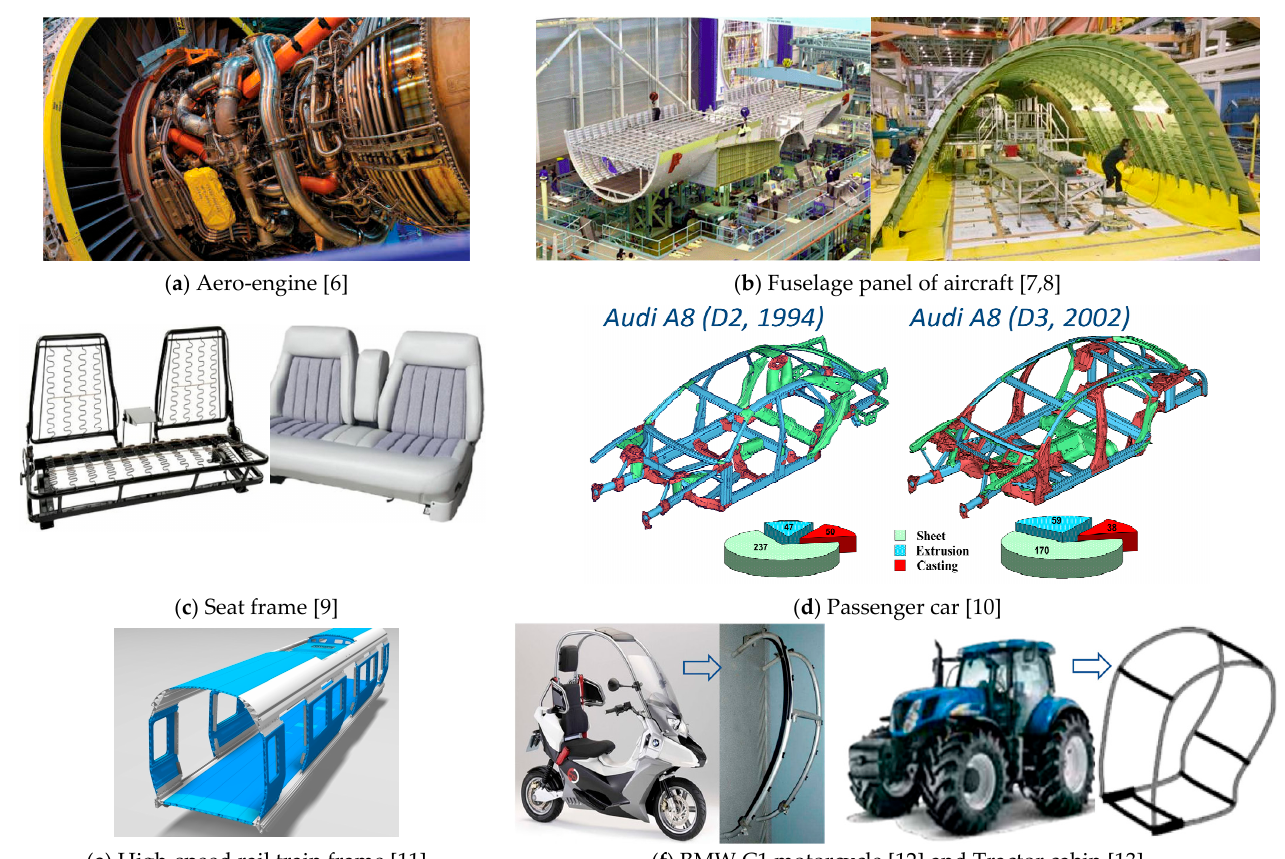
Figure 1. Typical applications of curved profiles in industries.